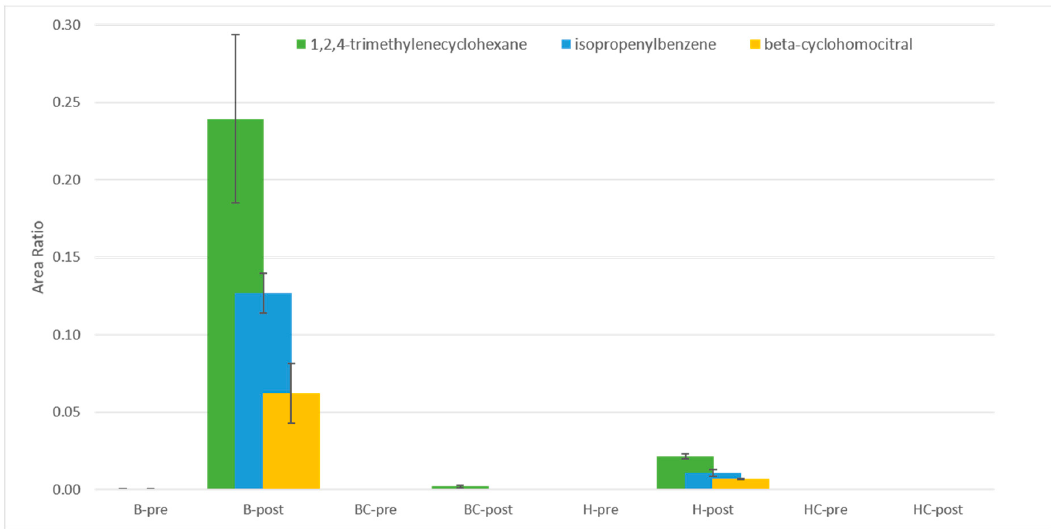
Figure 3. 1,2,4-trimethylencyclohexane, isopropenylbenzene, and beta-ciclohomocitral in honey wine before and after fermentation by S. cerevisiae EC1118. Samples were named as follows: B = blossom honey, BC = blossom honey with blackcurrant, H = honeydew honey, HC = honeydew honey with blackcurrant, pre = pre-fermentation, and post = post-fermentation.